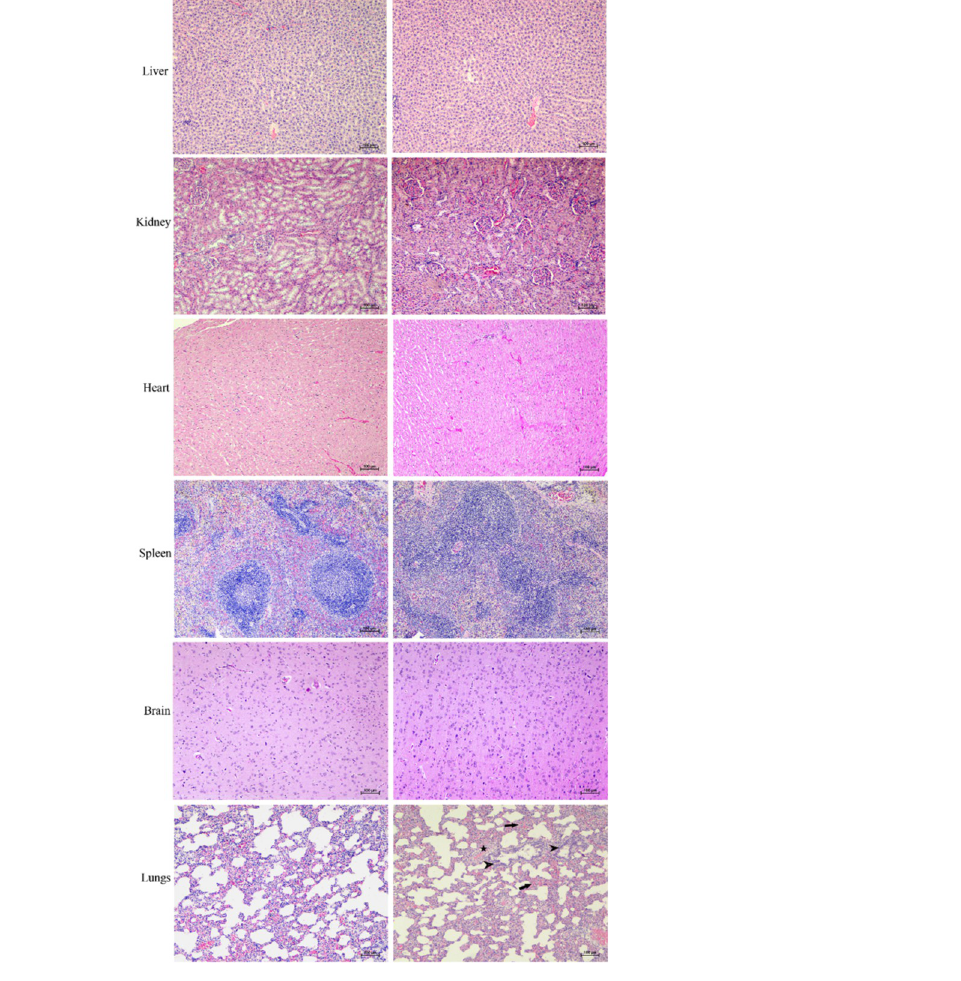
Fig 4. Effect of combined UA and OA exposure on histopathology of the vital organ in acute toxicity through MDI. The perturbations in the pathology of the lungs of the exposed rats have been marked with arrowhead (Magnification 10